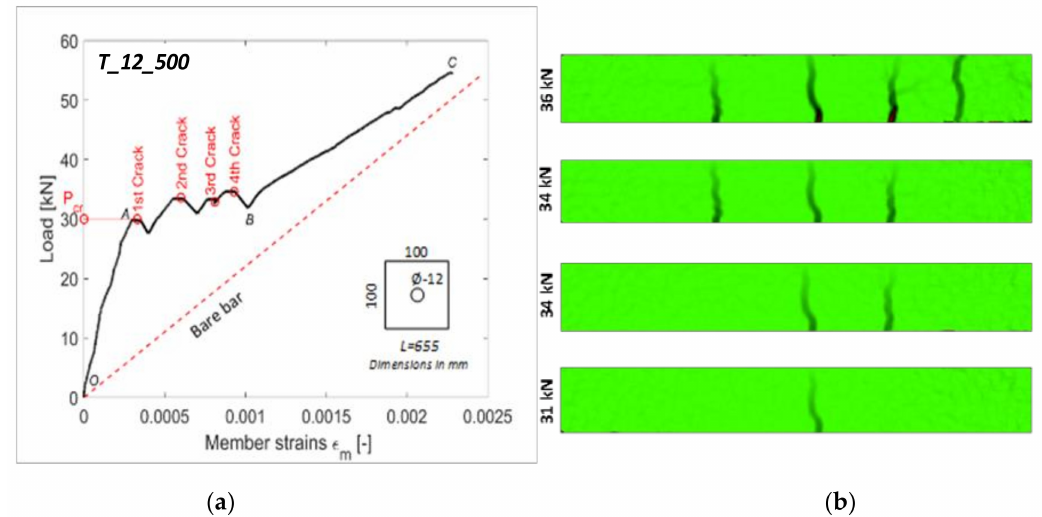
Figure 3. Failure behavior of a RC tie (study specimen) T_12_500: ( a ) experimental load–displacement diagram; and ( b ) development of crack with the corresponding loads through digital image correlation (DIC)